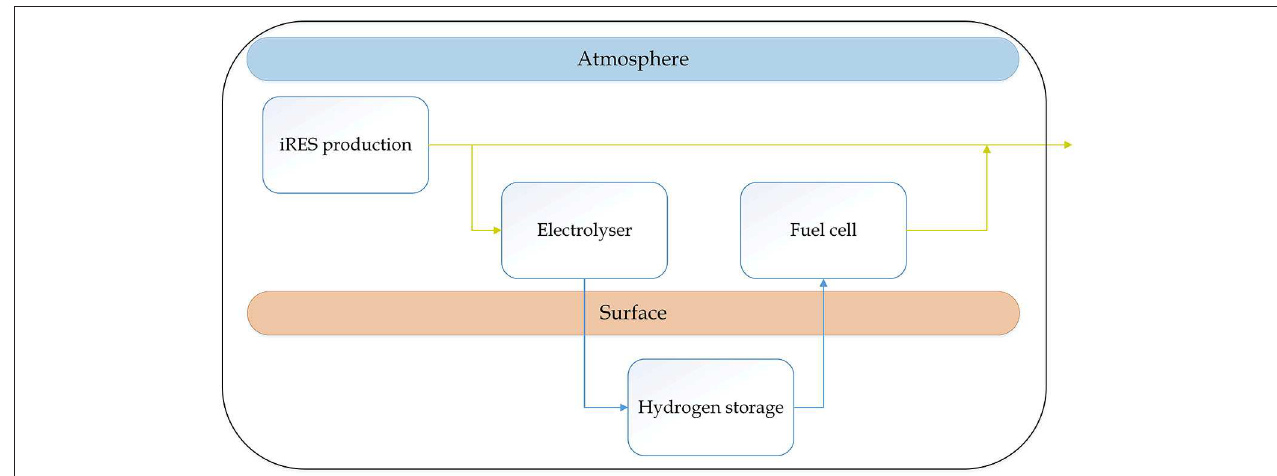
FIGURE 4 | System diagram of the P-H-P system: Yellow lines represent electricity, blue is hydrogen.